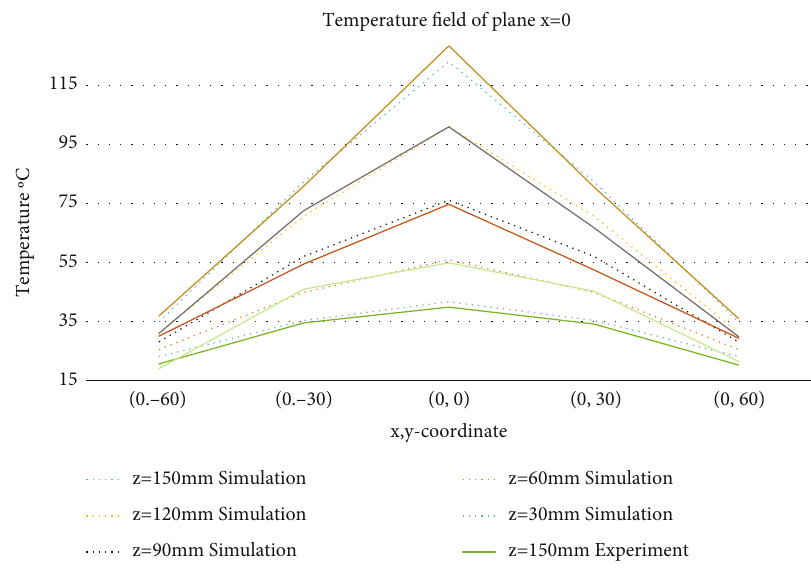
Figure 8: The distribution of the plane temperature when x = 0 . Table 1: The results of both simulation and